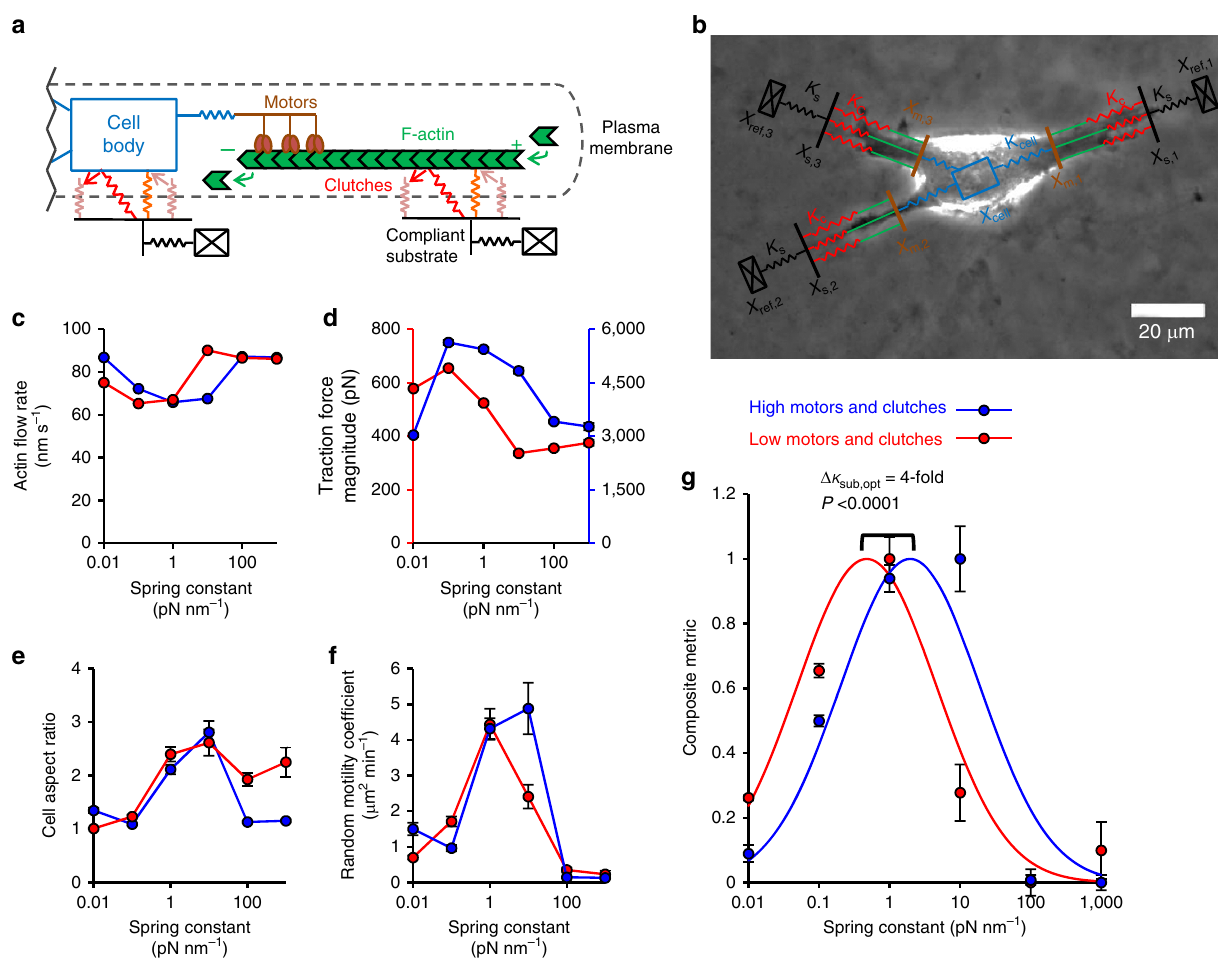
Figure 1 | Cell migration simulator. ( a ) Schematic of a motor–clutch module attached to the central cell body. Additional modules may also extend from the cell body but are not shown here for simplicity. ( b ) Representative schematic of the cell migration simulator overlaid on top of a phase-contrast image of U251 glioma cell. This image demonstrates how the simulator captures the three main protrusions of the cell. ( c – f ) Plots of simulator outputs for the cases of low (1,000 motors and 750 clutches) and high (10,000 motors and 7,500 clutches) are shown. ( c ) For the low case, the actin retrograde flow minimum occurs around a spring constant of 0.1pNnm (cid:2) 1 , and for the high case it occurs at B 1pNnm (cid:2) 1 . ( d ) For both the low and high number of motor and clutches cases, the traction force maximum occurs at B 0.1pNnm (cid:2) 1 and the high case producing B 10-fold more force. ( e ) For both low and high motors and clutches, cell aspect ratio has a maximum of B 10pNnm (cid:2) 1 . ( f ) For low motors and clutches, random motility coefficient peaks at B 10pNnm (cid:2) 1 , whereas for high motors and clutches, it peaks at B 1pNnm (cid:2) 1 . ( g ) The composite metric, created to mathematically combine all four metrics, and fit Gaussian curves’ peaks show a statistically significant shift in the optimum stiffness for the low and high motors and clutches cases ( P ¼ 0.0001). All error bars are s.e.m. The number of observations for each condition can be found in Supplementary Table